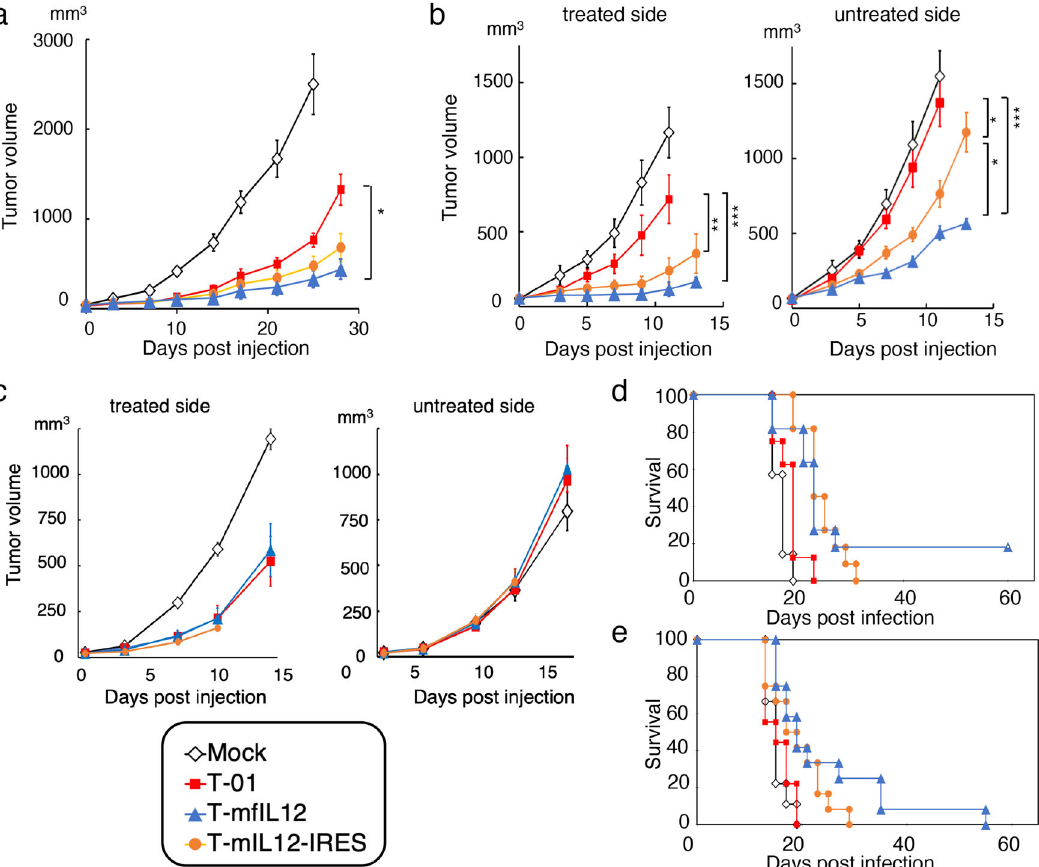
[Fig. 4e], log-rank test). Overall results indicate that T-mfIL12 exhibits higher in vivo ef fi cacy than